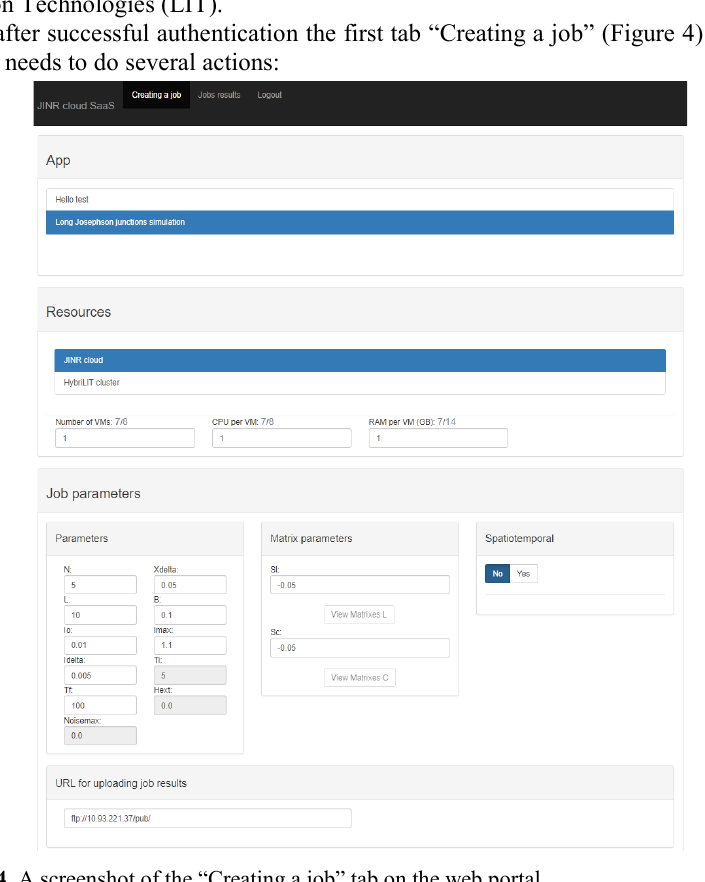
Fig. 4. A screenshot of the “Creating a job” tab on the web